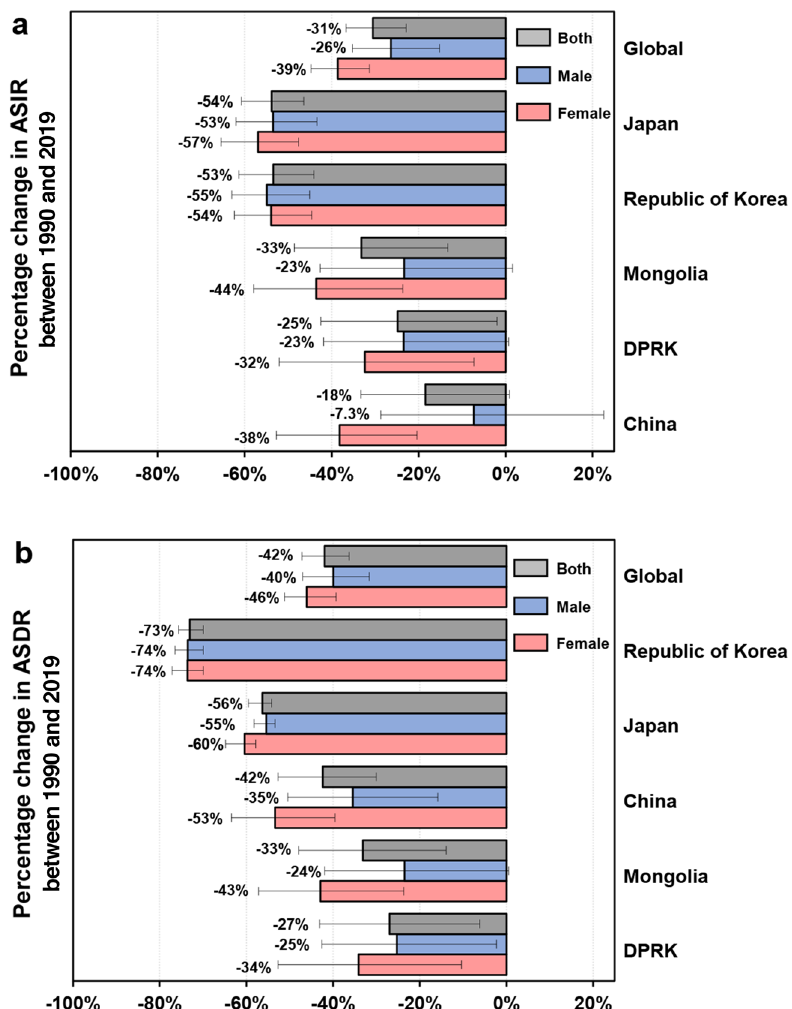
Figure 2. Percentage changes in ASIR ( a ) and ASDR ( b ) of gastric cancer worldwide and in five Asian countries between 1990 and 2019 according to sex. ASDR, age-standardized death rate. ASIR, age-standardized incidence rate. Error bars indicate 95% uncertainty